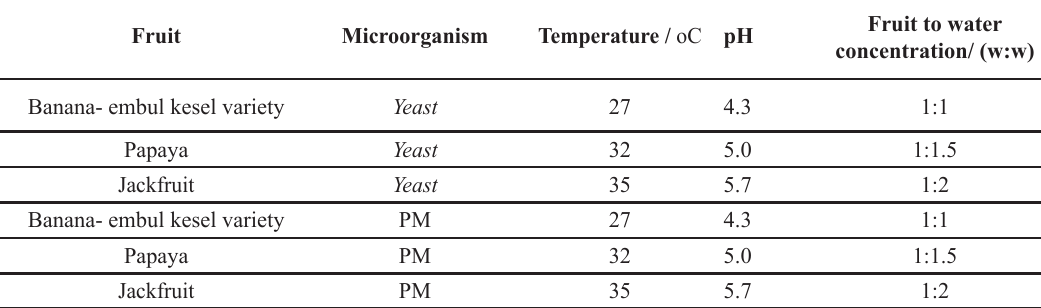
Fruit to water concentration/ (w:w)